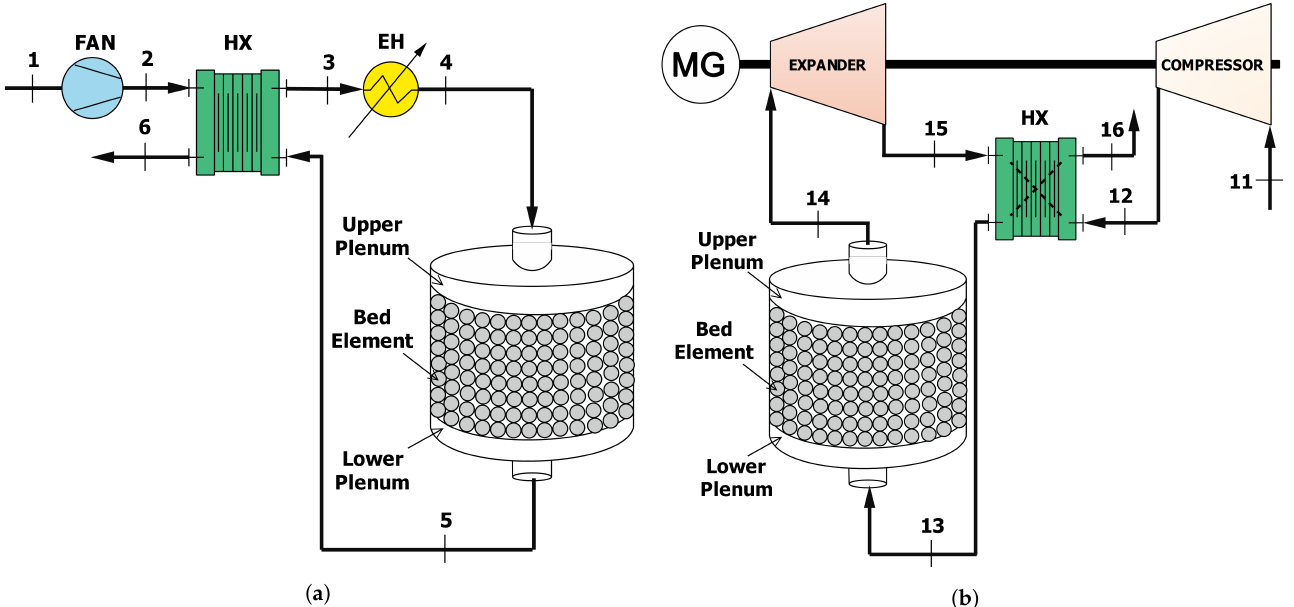
Figure 5. Schemes of the plant used as a test case: ( a ) Charging layout, ( b ) Discharge arrangement. The working fluid adopted in both charge and discharge is air. The system components are: a fan (FAN), an electric heater (EH), a heat exchangers (HX), an electric motor/generator (MG), a compressor, an expander and the storage